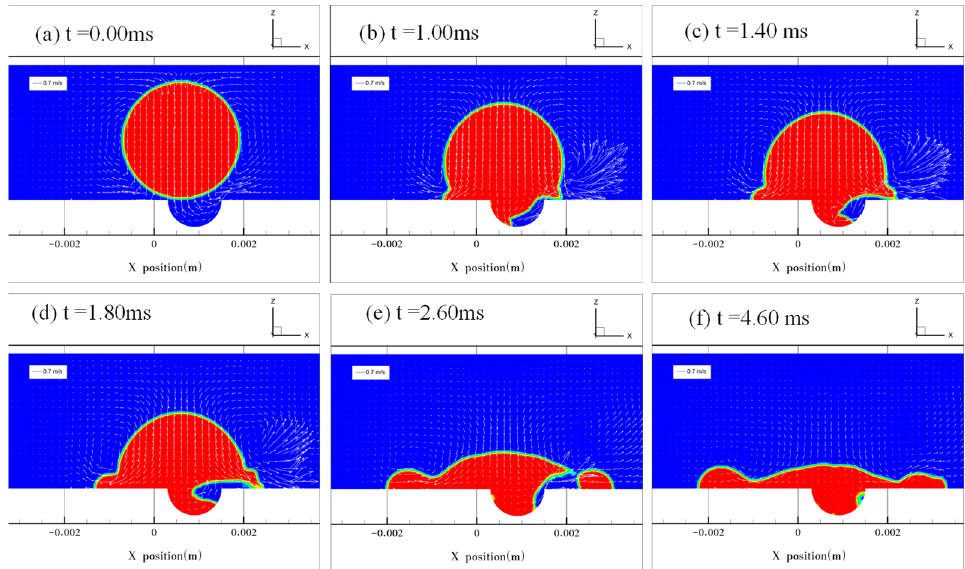
Figure 6. Droplet impacting the dimpled surface at e = 0.25. ( a ) The droplet starts to impact the surface when t = 0.00 ms. ( b – d ) The process of droplet spreading over the dimple, with air trapped inside the dimple. ( b – d ) the air is pushed from the center to the right side of the dimple. ( e ) Air evacuated the dimple at t = 2.60 ms. ( f ) The droplet reaches its maximum spreading diameter.